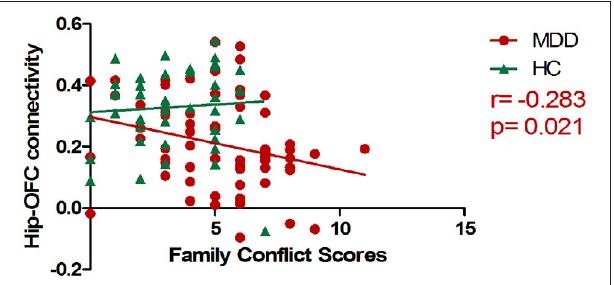
FIGURE 2 | The scatter plots of the correlations between mean hippocampal-OFC functional connectivity and family conflict scores. The RSFC between the left hippocampus and bilateral OFC was negatively associated with the conflict scores of FES-CV in the MDD group (OFC, orbital frontal cortex; FES-CV, Chinese version of the Family Environment Scale; Hip, Hippocampal; HC, healthy control; MDD, major depressive disorder).